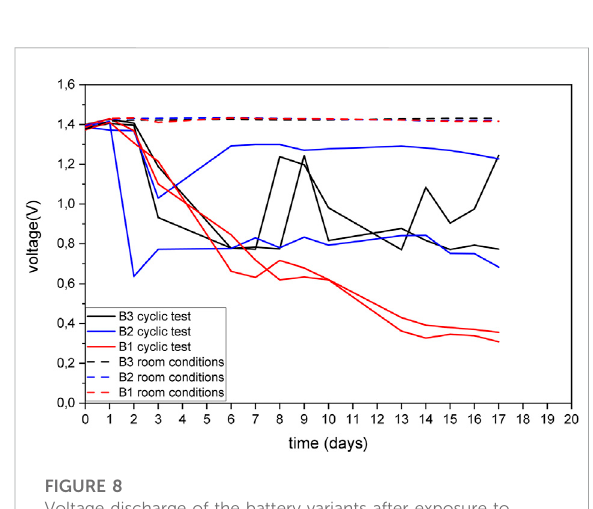
Voltage discharge of the battery variants after exposure to wet and dry and room